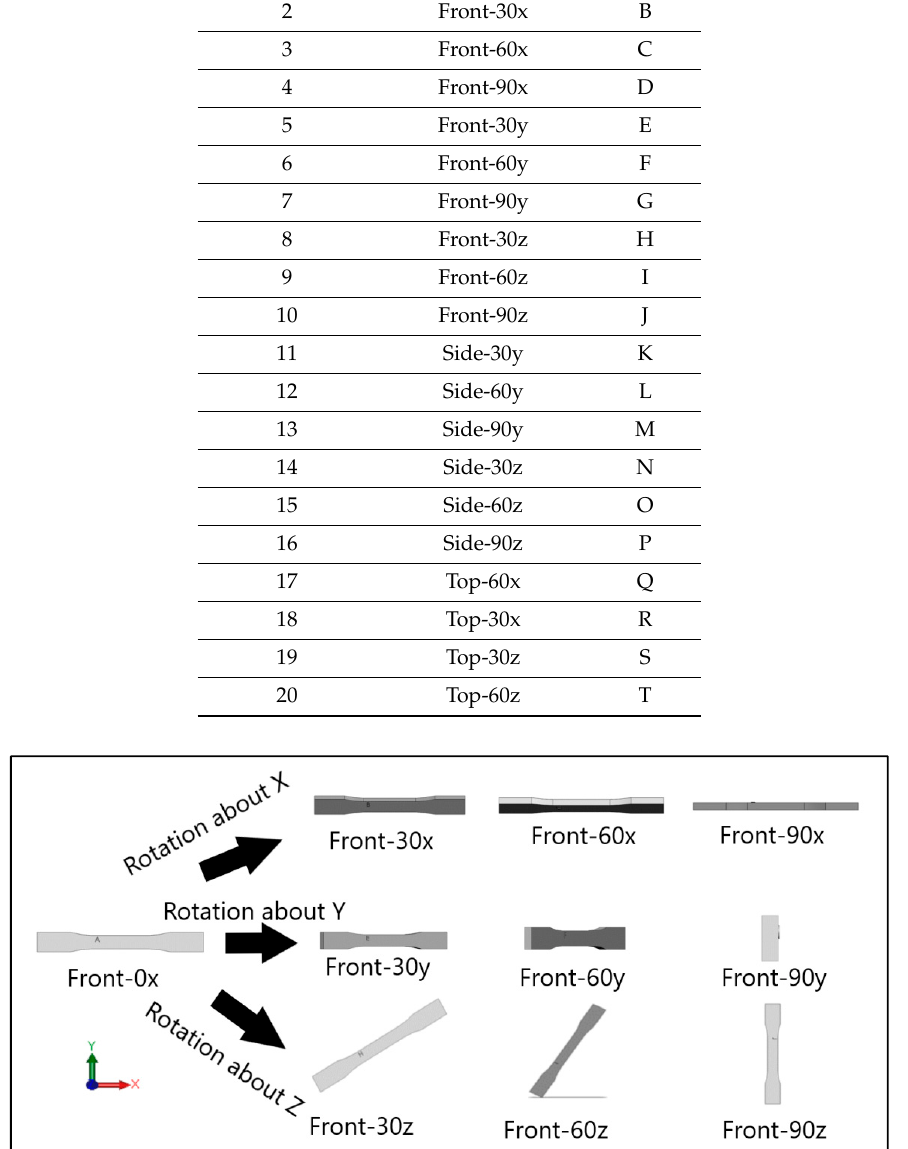
Table 1. Design of experiments.